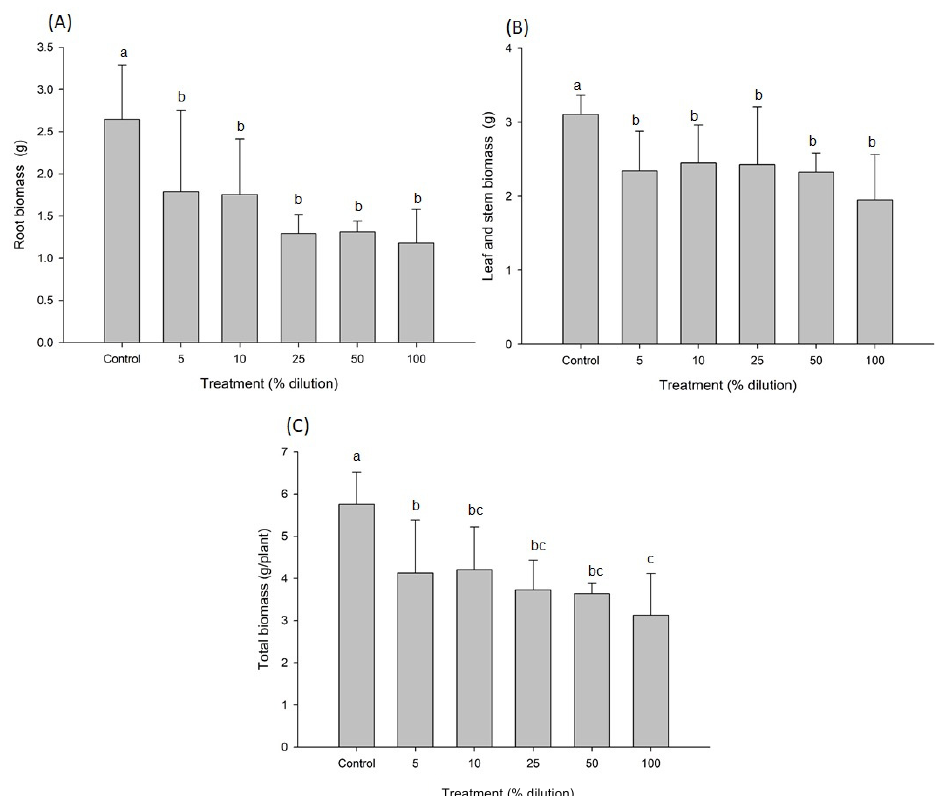
Figure 6. Average biomass production in ( A ) root and ( B ) leaves and stems, and ( C ) total biomass of Rhizophora mangle seedlings between treatments. The error bars represent the standard deviation. Treatments that do not share a letter are significantly different ( p < 0.05).